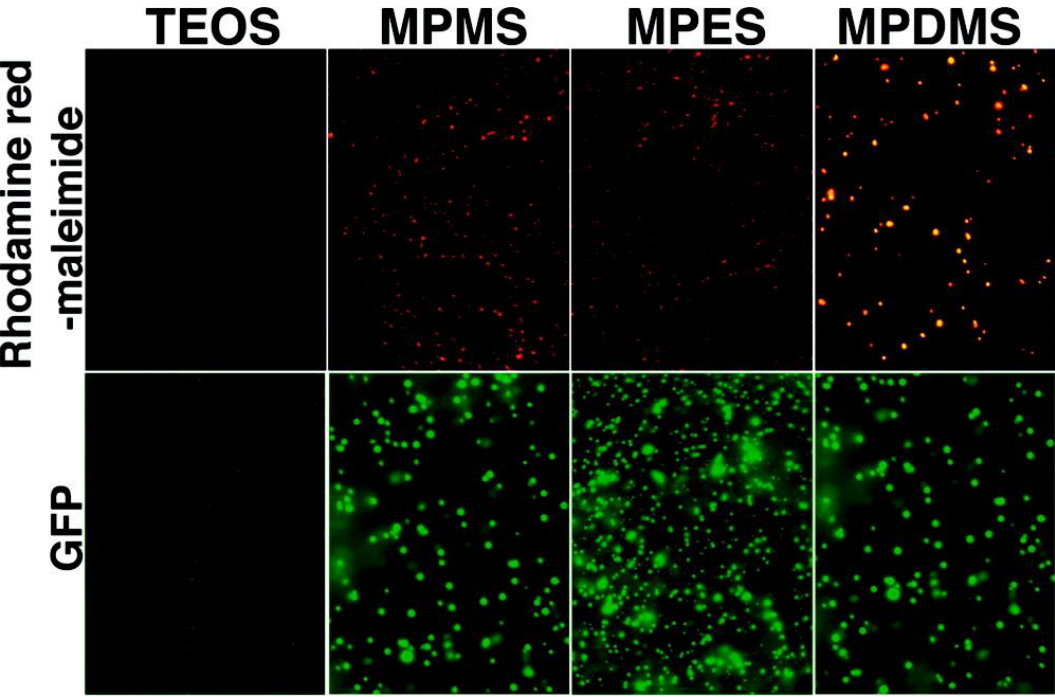
Figure 3. Fluorescence microscopy images of surface modified thiolated organosilica and TEOS nanoparticles. The nanoparticles were mixed with rhodamine red maleimide (upper panels) and GFP (lower panels). TEOS: Tetraethylorthosilane, MPMS: 3-mercaptopropyltrimethoxysilane, MPES: 3-mercaptopropyltriethoxysilane and MPDMS: 3-mercaptopropylmethyldimethoxysilane. Reprinted with permission from [34] . Copyright (2008) American Chemical Society.